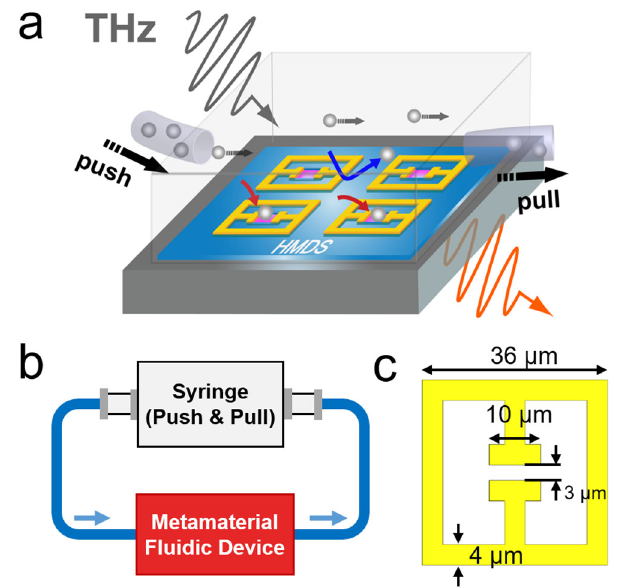
Figure 1. ( a ) Schematic of surface-functionalized fluidic THz metamaterials for microplastic detection in the aqueous environment. The gap area is coated by adhesive polymer (pink area), whereas it is coated by HMDS (blue area), which repels the microplastics. ( b ) Schematic for the experiments in which the fluidic metamaterials device is connected to a peristaltic pump for the fast circulation of the analyte solution. ( c ) SRR pattern design used in this work.